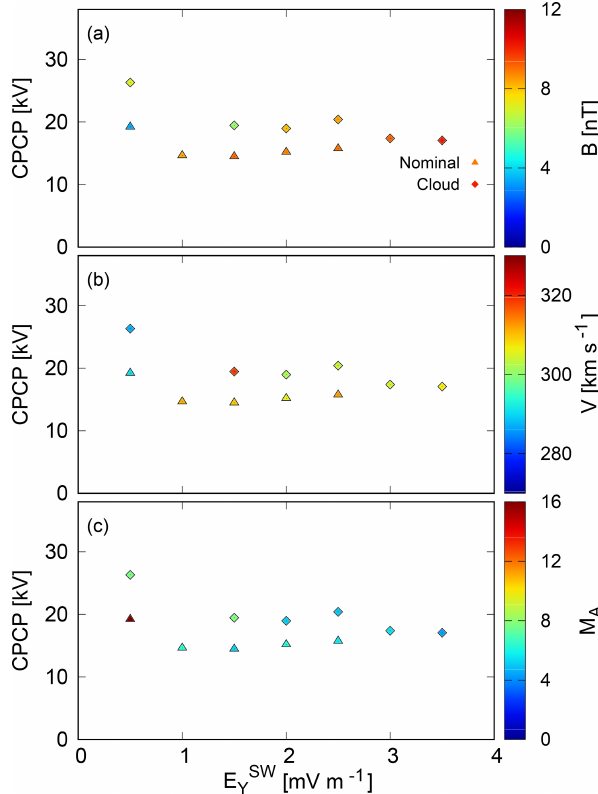
Figure 8. The cross-polar cap potential (CPCP) as a function of the IMF E Y for the 2012 ICME sheath and cloud periods, with nomi- nal solar wind conditions before and after the ICME event taken into account separately. GUMICS-4 simulation data with 1min time res- olution have been averaged by 10min and binned by upstream E Y with 1.0mVm − 1 intervals. Panels (a) , (b) and (c) show the mag- nitudes of the IMF, the upstream flow speed and the Alfvén–Mach number, respectively.